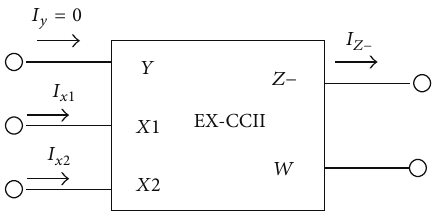
Figure 2: Symbol of EXCCII with buffered output.